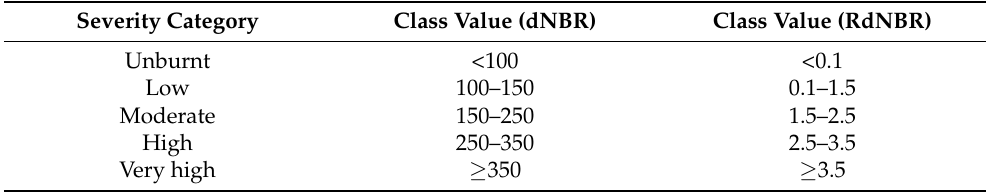
Table 3. Burn severity category and classification threshold for dNBR and RdNBR raster layers. The class value of dNBR is scaled to 1000. The classification threshold was adopted from Cai and Wang